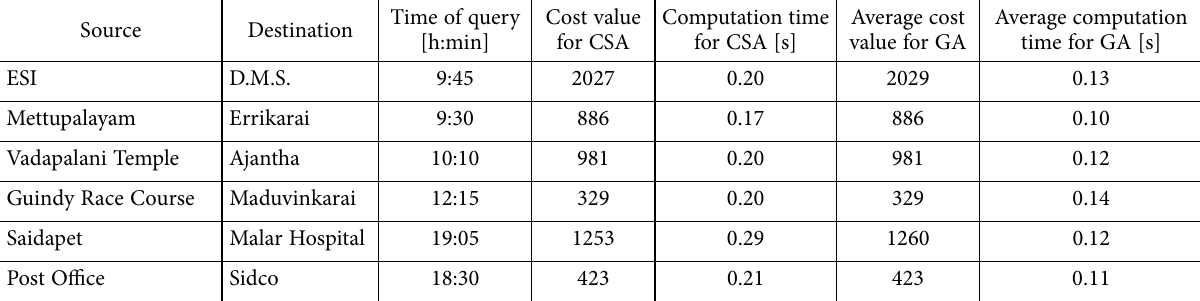
Table A3. Comparison of average computation time for additional examples (real-time